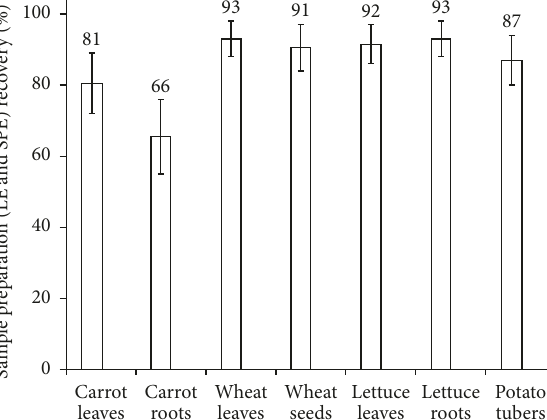
Figure 3: Average sample preparation (LE and SPE) recoveries ( 𝑛 = 2 ) of 5 antimicrobials (CIP, ciprofloxacin; NOR, norfloxacin; OFL, ofloxacin; SDM, sulfadimethoxine; SMX, sulfamethoxazole) from different parts of food plants grown in loamy soil using LE and SPE. Error bars show the recovery